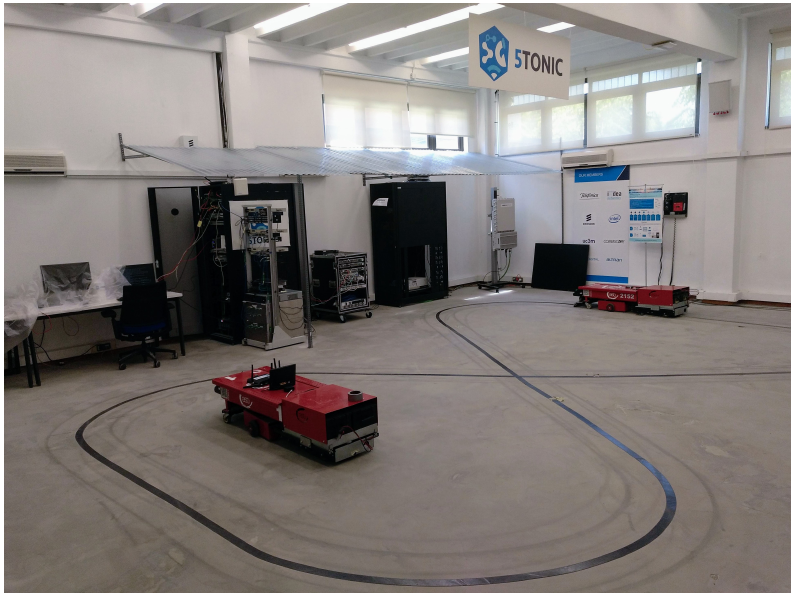
Figure 3. AGV circuit in